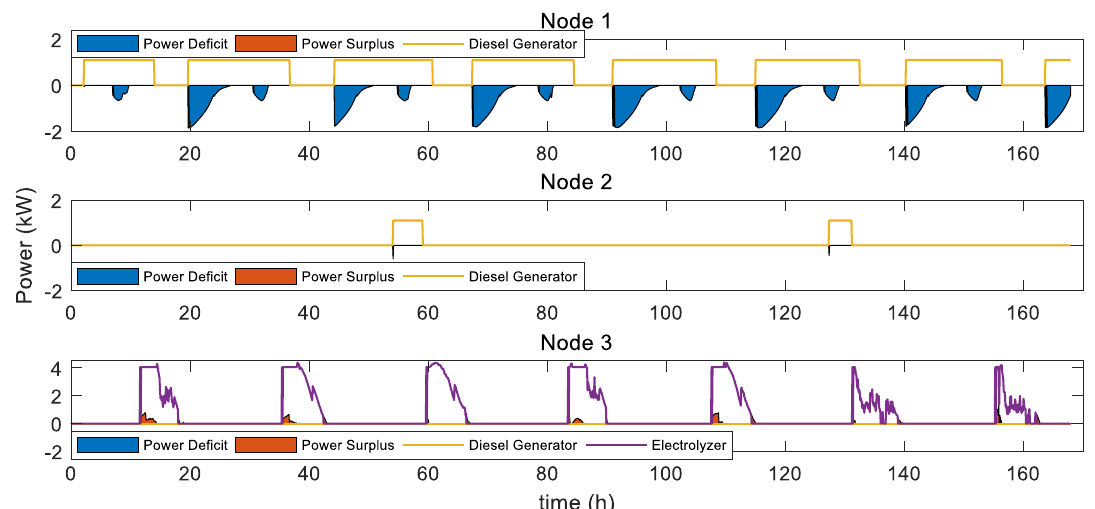
Figure 19. Auxiliary power systems usage (diesel generator, electrolyzer) and total power shortage/surplus at each node in weekly operation.